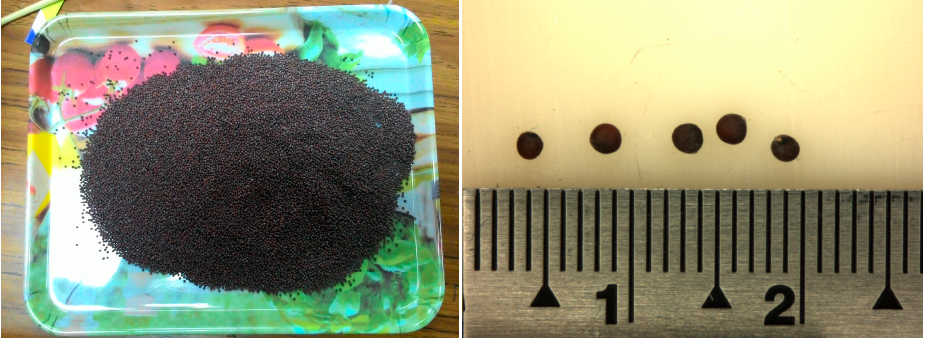
Figure 1. Chinese cabbage seeds.